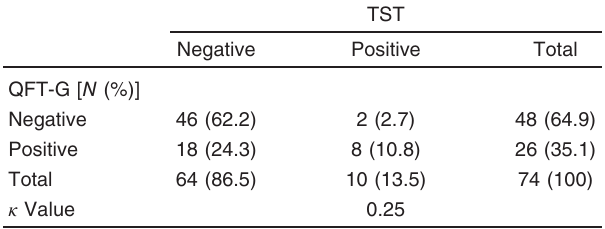
Table 4 Agreement between the results of QuantiFERON- Tuberculosis Gold with the results of tuberculin skin